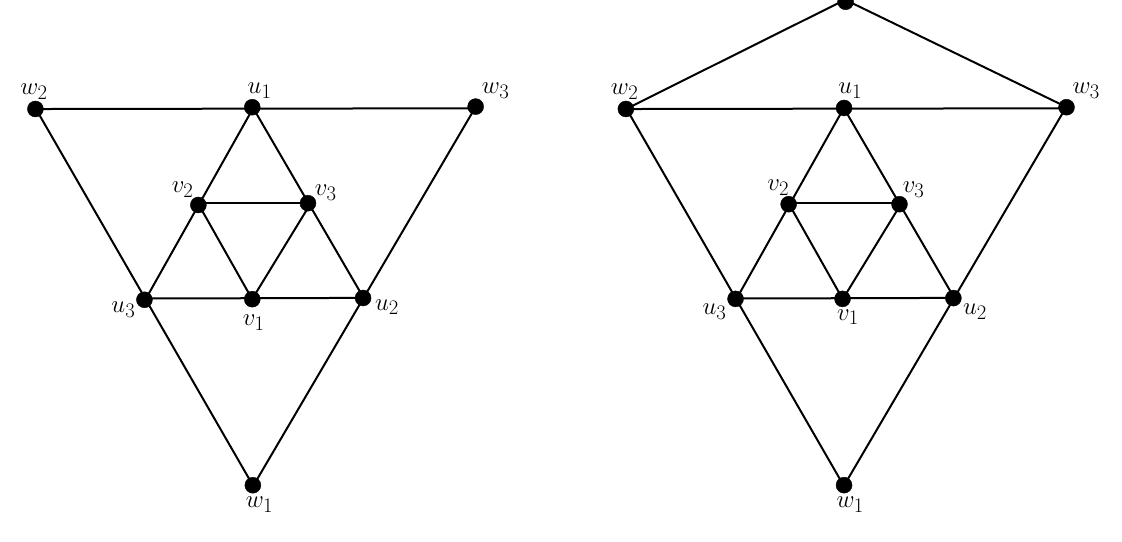
Figure 2: The graph G 9 (left) and the graph G 10